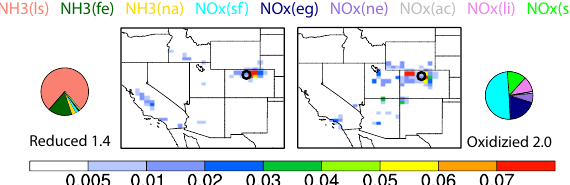
Figure 7. Same as Fig. 5 but for oxidized and reduce Nr deposition in RM. Units for the pie charts and colorbar arekgNha − 1 yr − 1 . The sum of the oxidized and reduced Nr deposition is smaller than the inset number in Fig. 5 because the number here excludes Nr from “other species”.